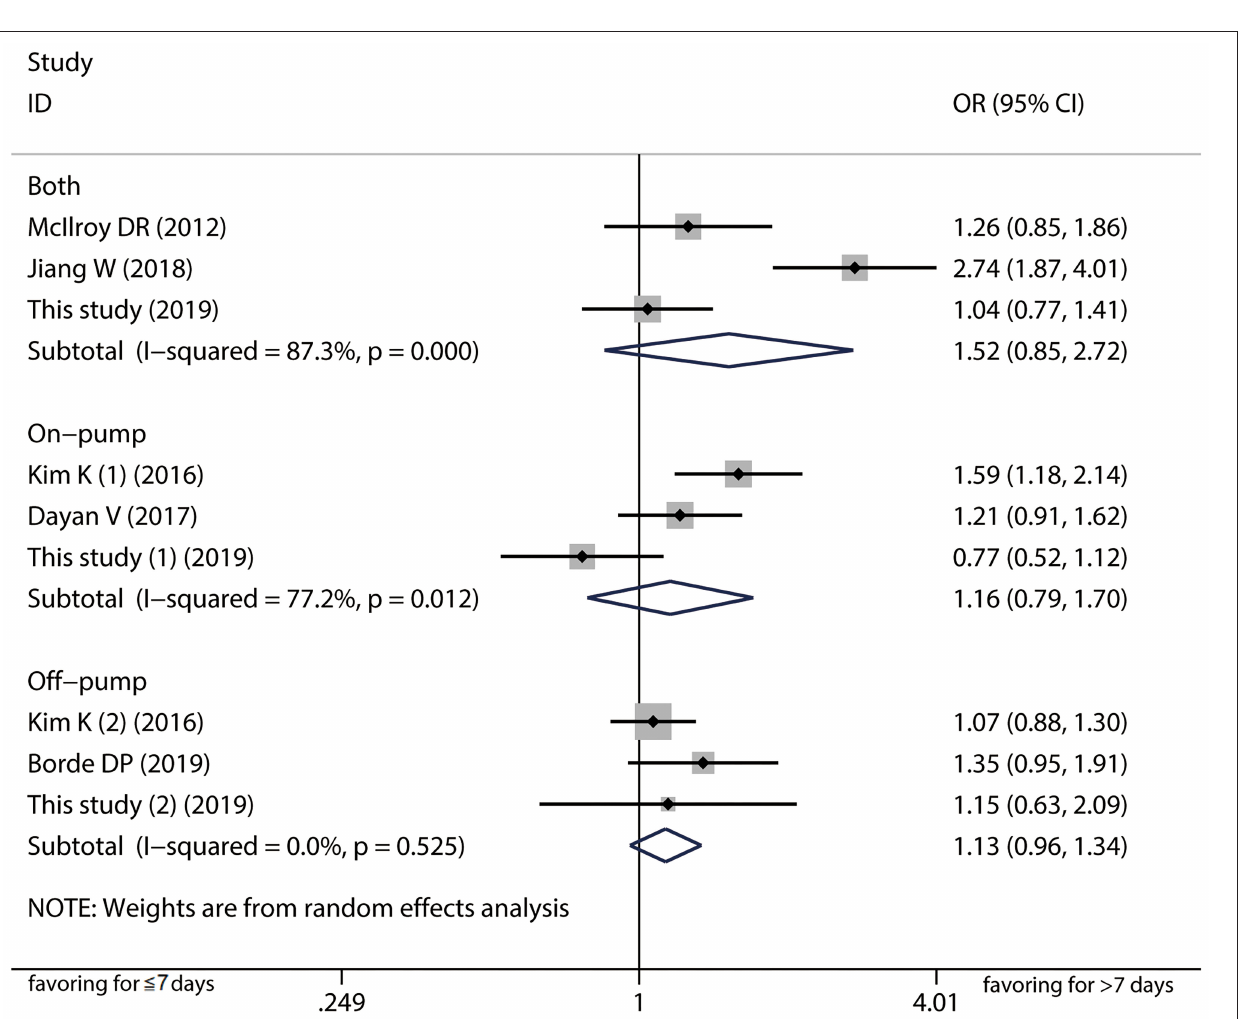
Frontiers in Medicine |